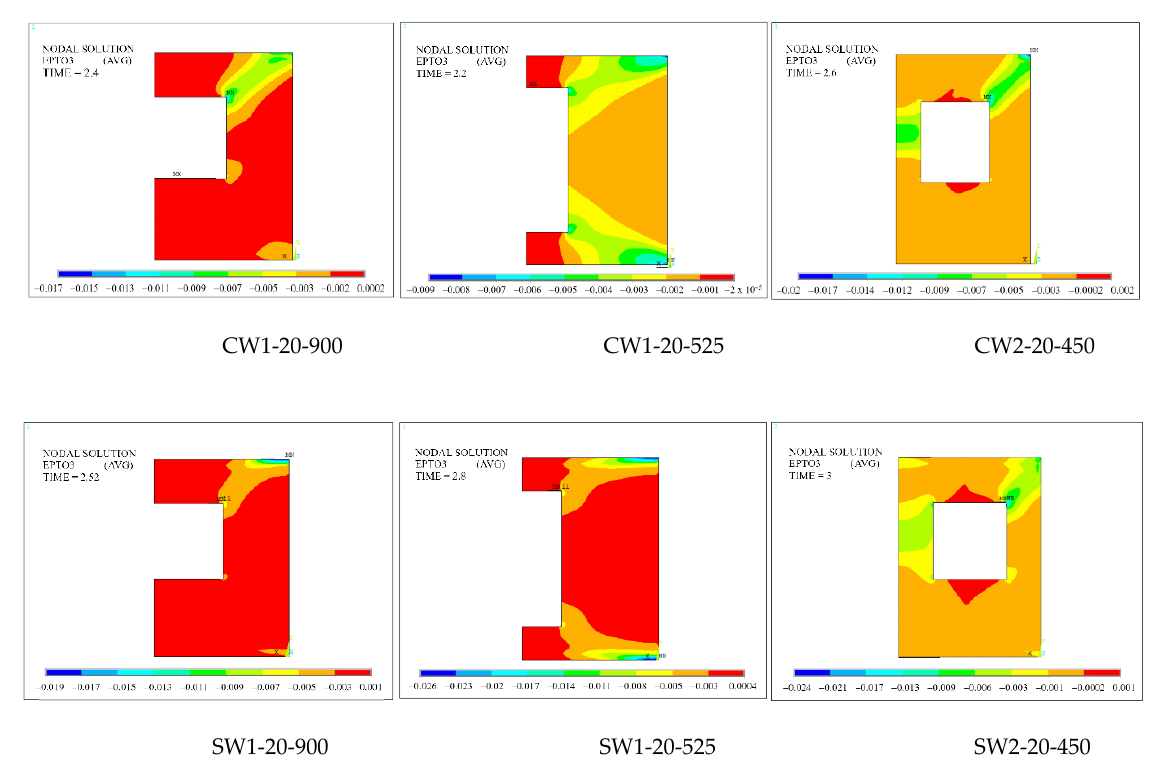
Figure 11. Concrete compressive strains in walls with window opening area ratio of 20%.